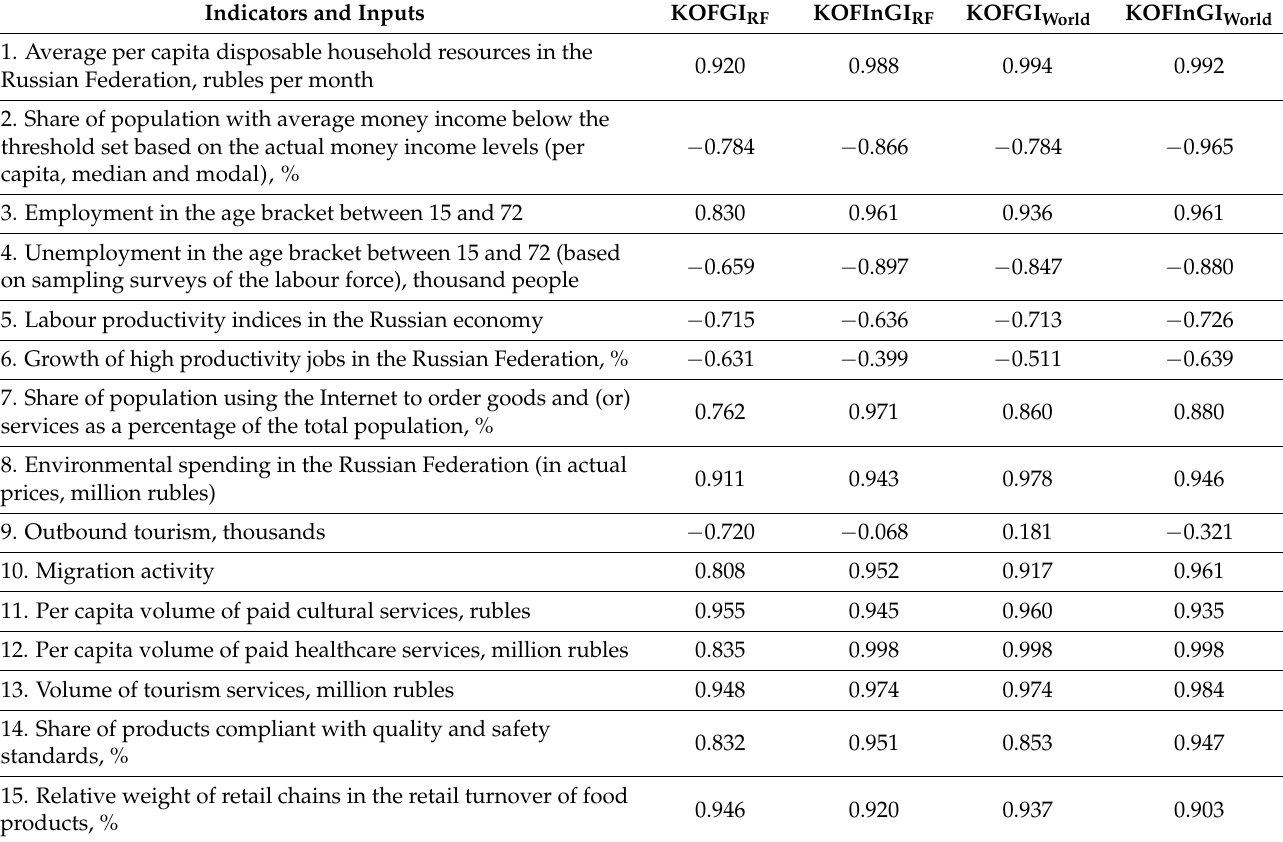
Table 1. Correlation between globalisation processes and indicators of development of information society, socioeconomic, cultural, retail and other processes in the Russian Federation. Indicators and